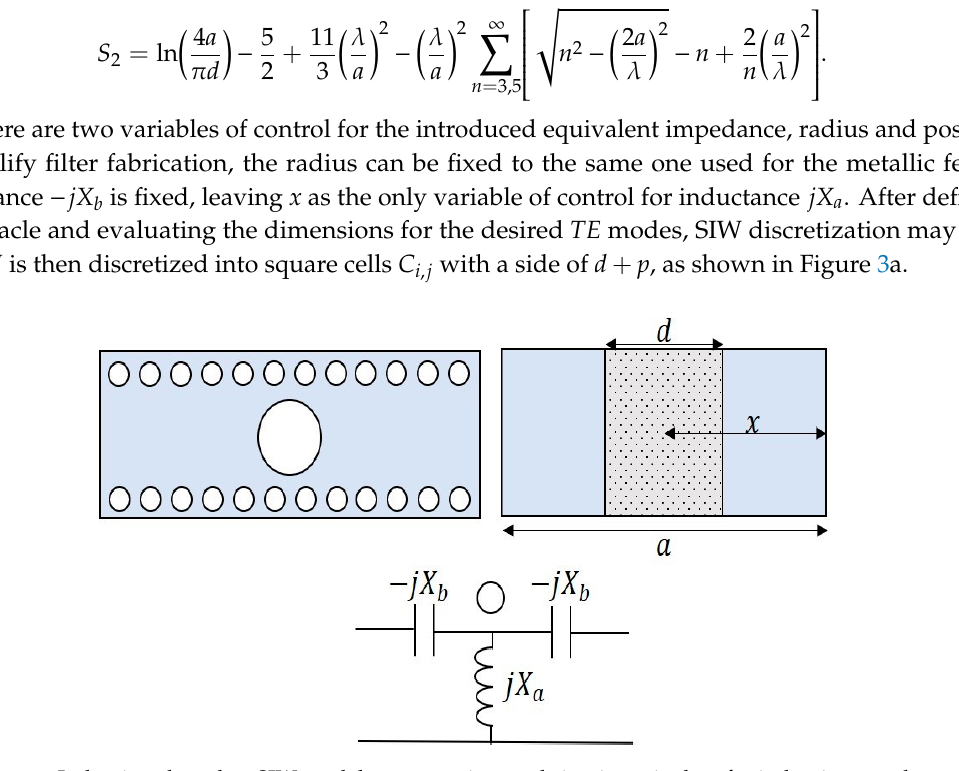
Figure 2. Inductive obstacles: SIW model, cross-section, and circuit equivalent for inductive metal post.